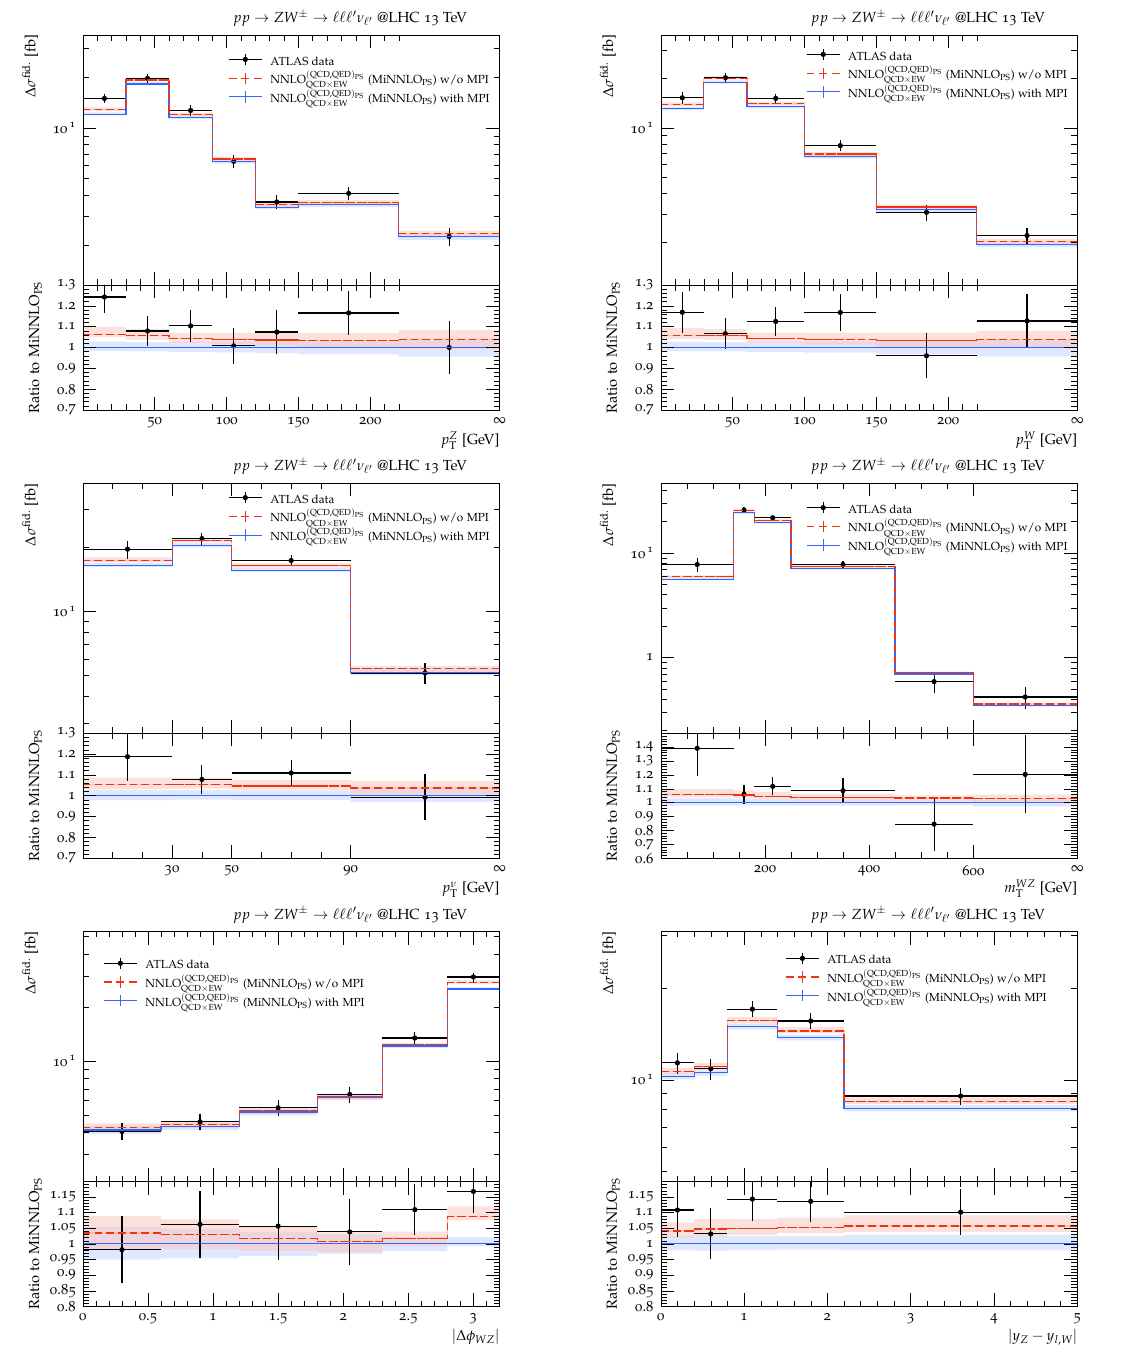
Figure 8. Comparison of our default MiNNLO PS prediction NNLO (QCD , QED) PS (blue, solid) and without (red, dashed) against the ATLAS data from the analysis